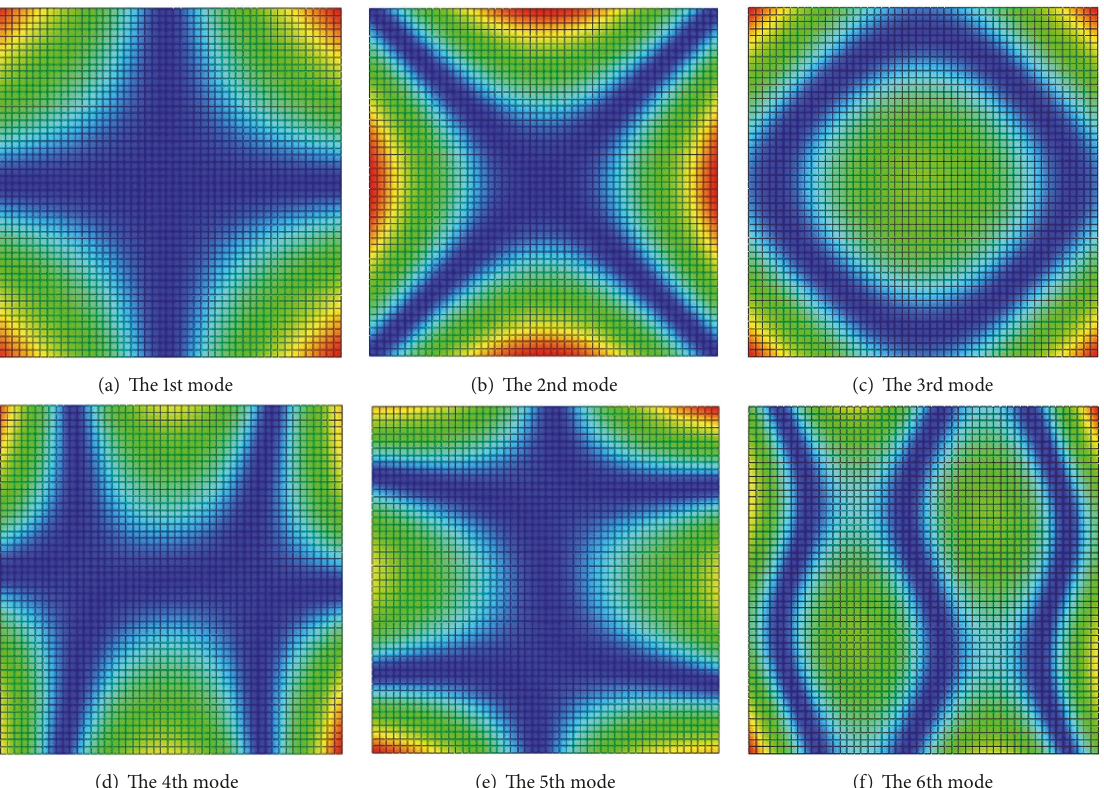
Figure 4: The first six mode shapes of square rectangular plates with completely free boundary conditions calculated by FEA method. Table 3: Frequency parameters Ω = 𝜔𝑏 2 (𝜌ℎ/𝐷) 1/2 /𝜋 2 for the rectangular plate of case 2 with restraining stiffness, 𝜉 𝑘 each point